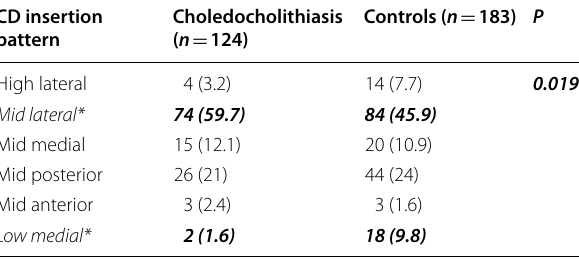
The p values of comparisons with significant (p<0.05) intergroup difference are represented as bold and italics * Post hoc tests revealed significant difference between groups only for mid- lateral and low-medial insertions